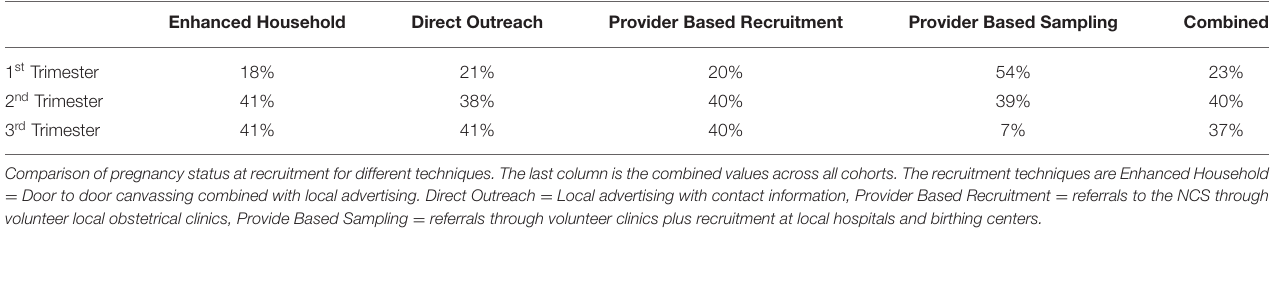
TABLE 3 | NCS vanguard study gestational age at recruitment. Enhanced Household Direct Outreach Provider Based Recruitment Provider Based Sampling